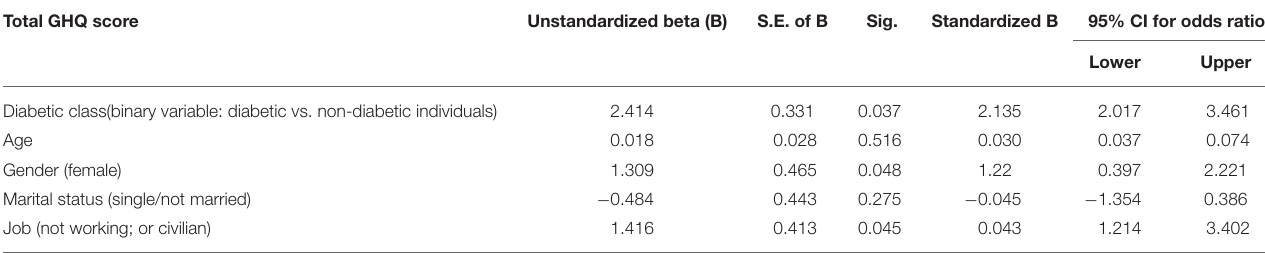
TABLE 3 | Multiple linear regression model regressing total GHQ score on diabetic class and other sociodemographic factors ( n = 1,018).